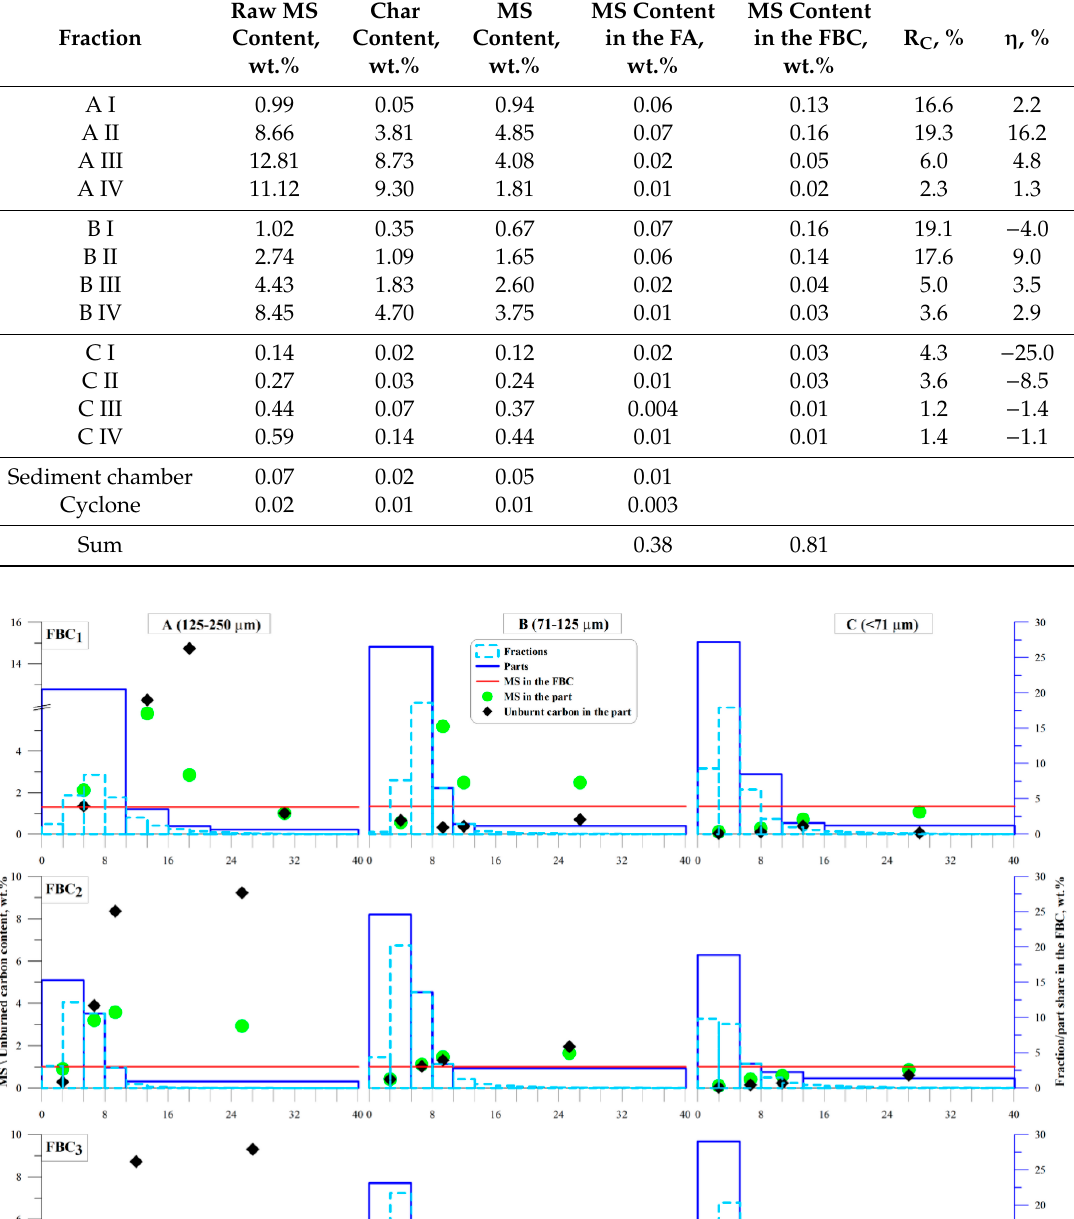
Table 5. The MS content in the fly ash FA 3 fractions.